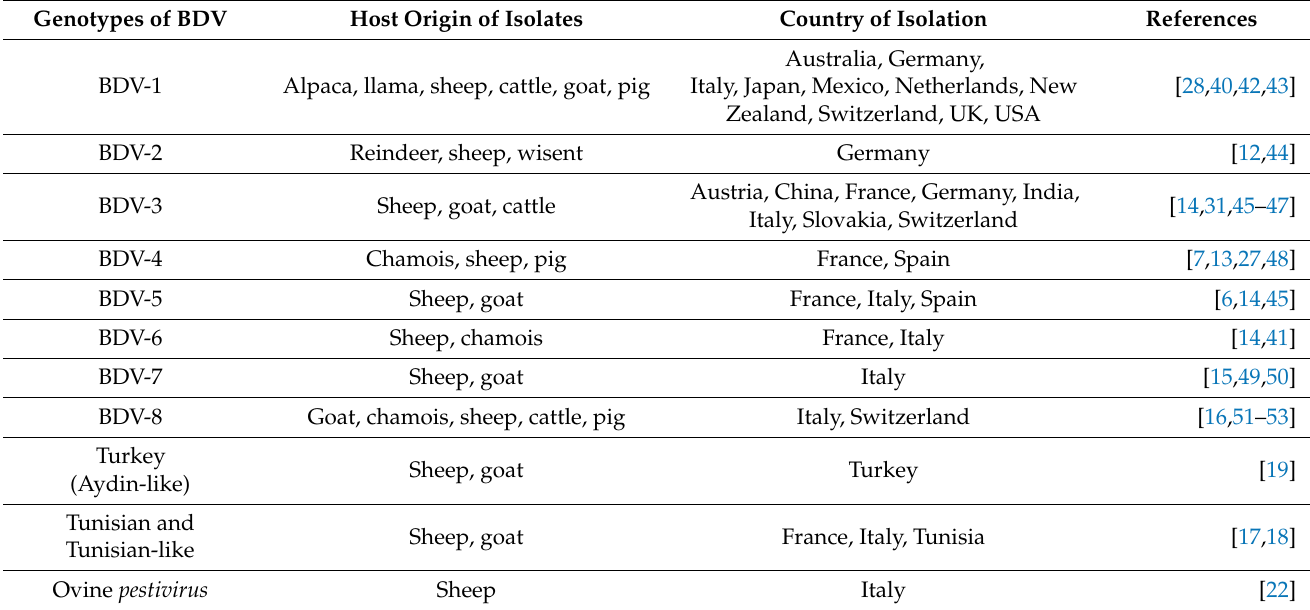
Table 1. BDV genotypes and other ruminant pestiviruses according to the host species. Genotypes of